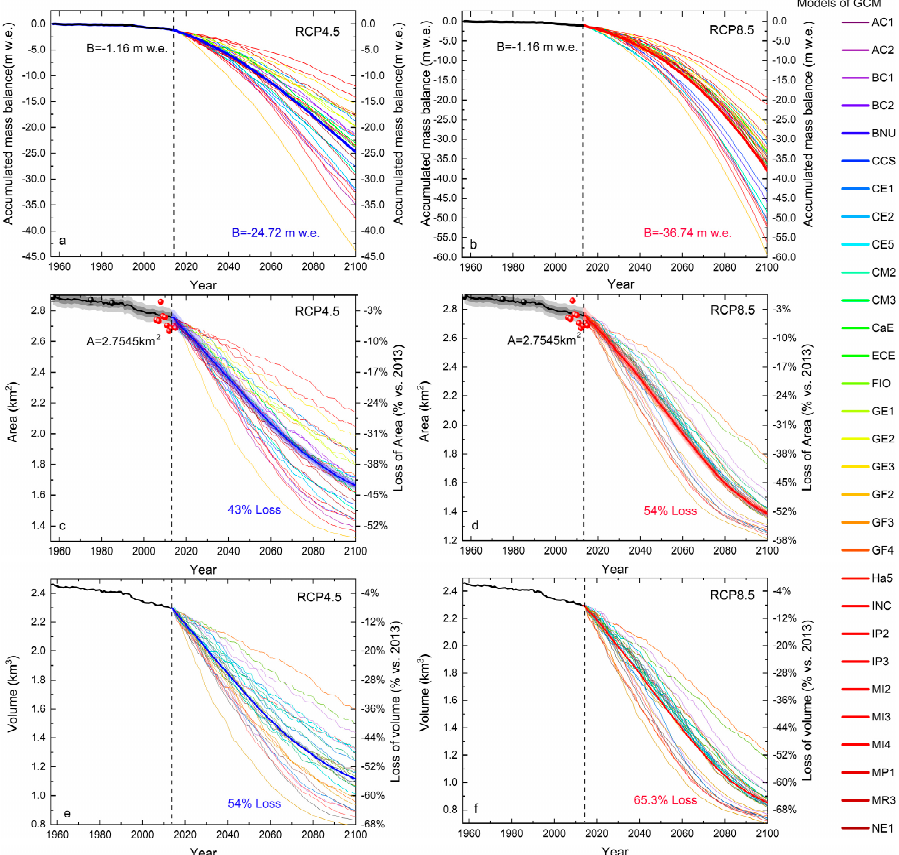
Figure 13. The accumulated mass balance ( a , b ), area ( c , d ), and volume ( e , f ) of the Qiyi glacier during 1957–2100 under RCP 4.5 and RCP 8.5 climate scenarios by using multi-model outputs of GCM. The black balls in c and d refer to the observed areas of the Qiyi glacier; the red balls in c and d refers to the areas gained from Landsat EM+. The thick lines in the a – f indicate the mean values.